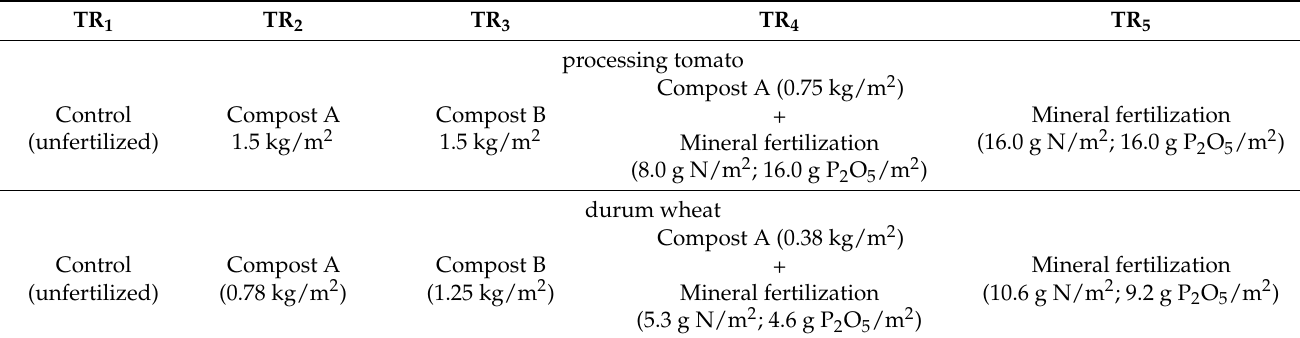
Table 5. Fertilization treatments applied to tomato and durum wheat